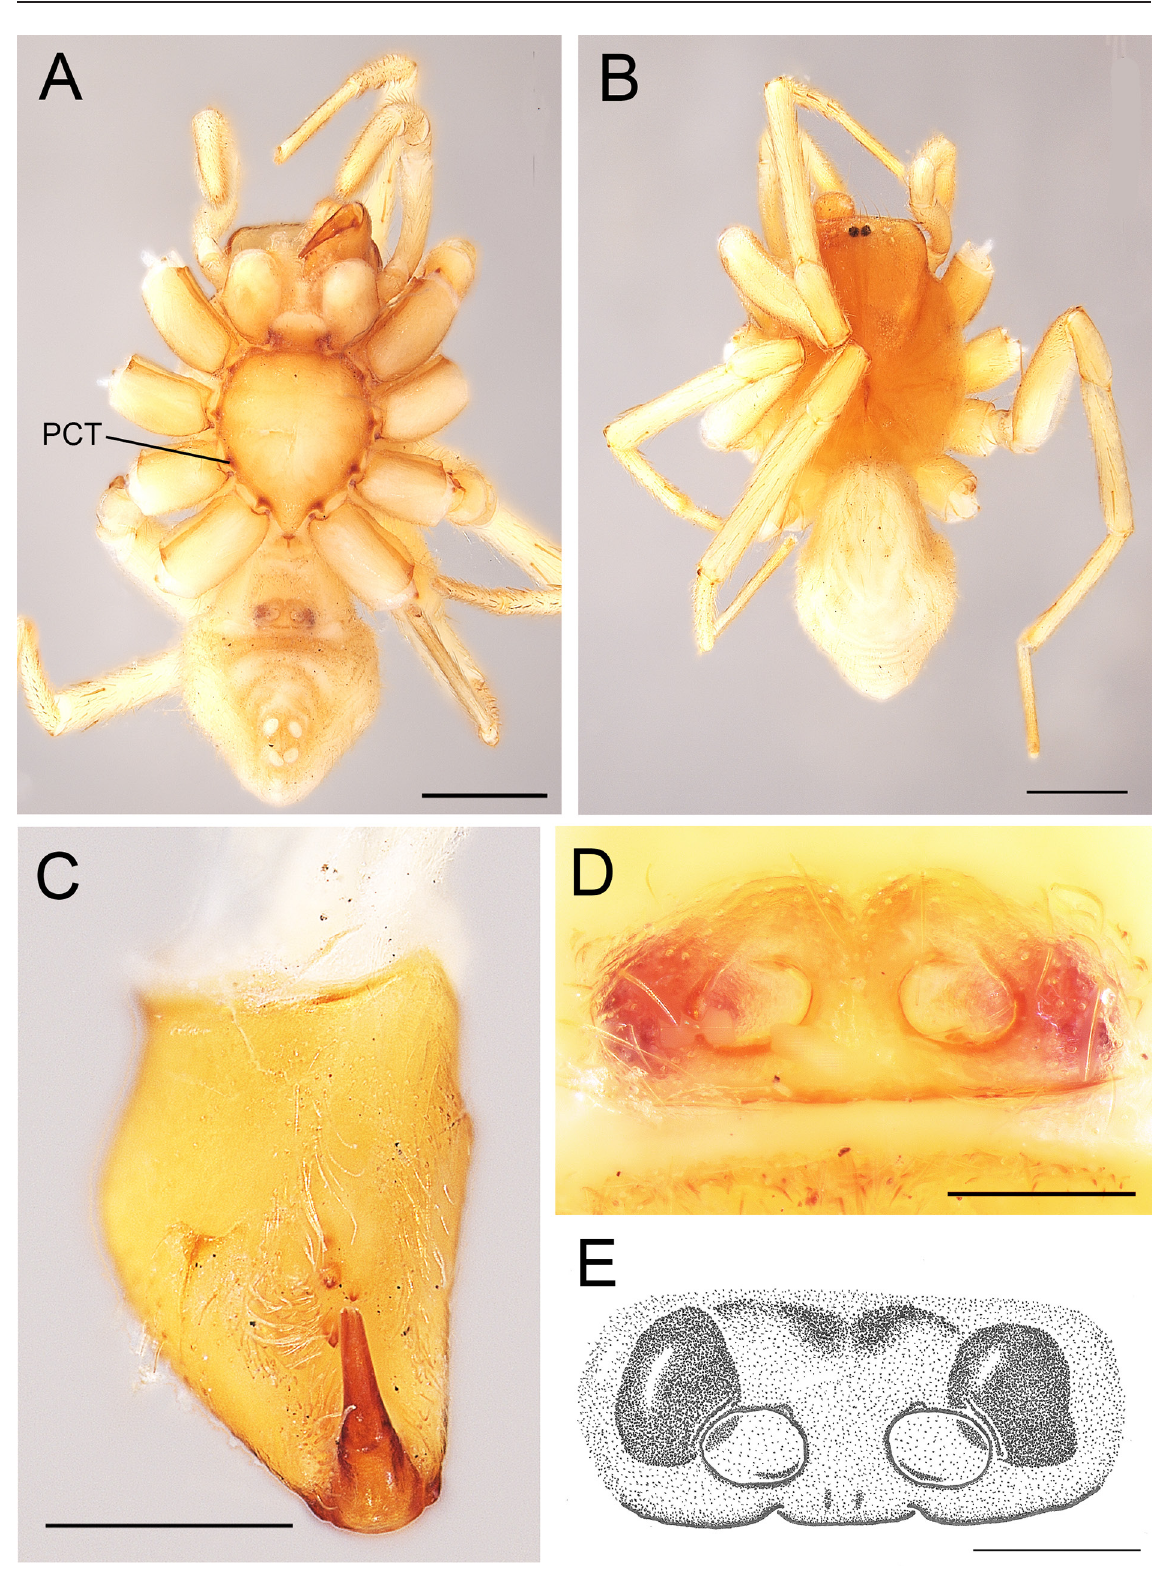
Fig. 11. Andromma bouvieri Fage, 1936, ♀, lectotype (MNHN AR3103). A . Habitus, ventral view. B . Same, dorsal view. C . Right chelicera, median view. D – E . Epigyne, ventral view. Abbreviation: PCT = precoxal triangles. Scale bars: A–B = 1 mm; C = 0.5 mm; D = 0.2 mm; E =